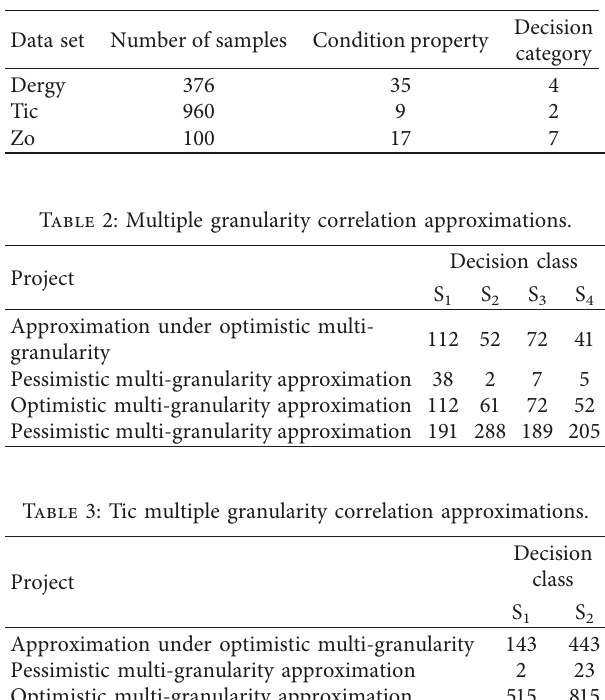
Table 1: Data description.